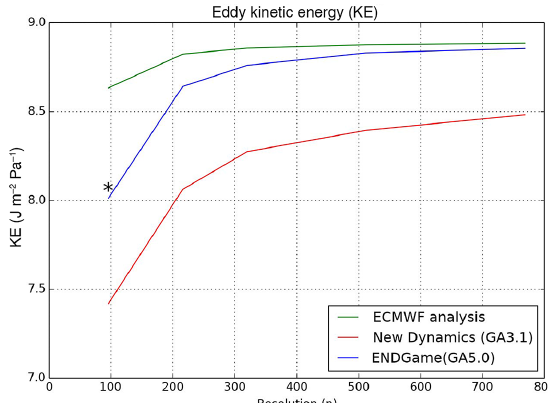
Figure 9. Eddy kinetic energy from sets of 12 3-day forecasts run from ECMWF analyses as a function of resolution compared to the verifying analyses reconfigured to those resolutions. Cubic interpo- lation of the departure point is used in the simulations shown in this plot; however, the black asterisk marks GA4 at N96 with quasi- cubic